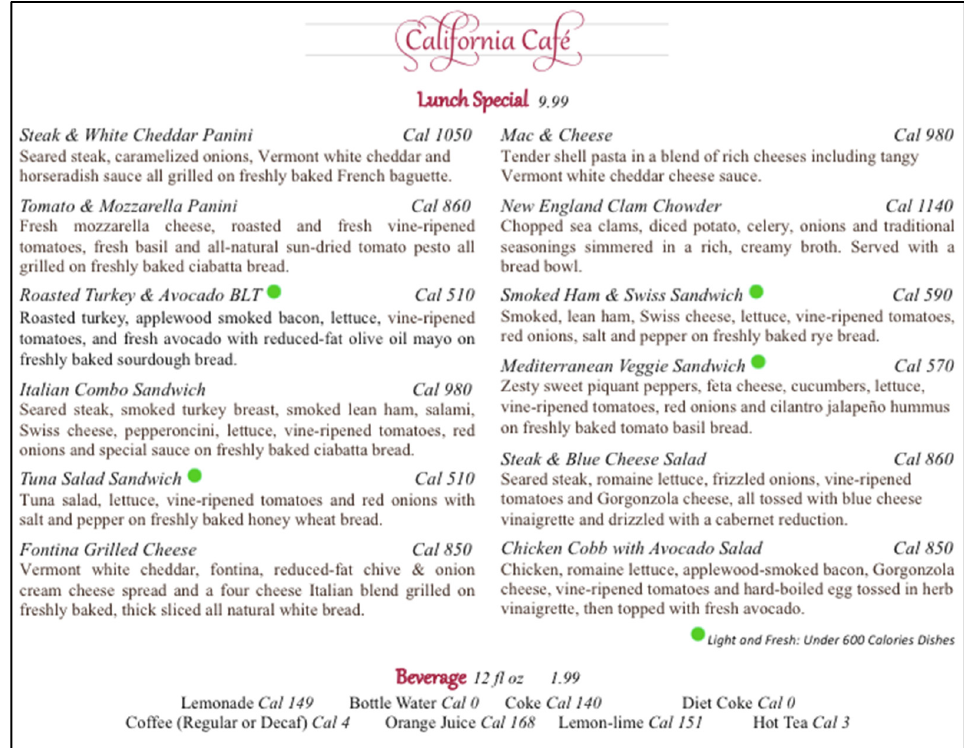
Figure A8. California Cafe Light and Fresh Menu.